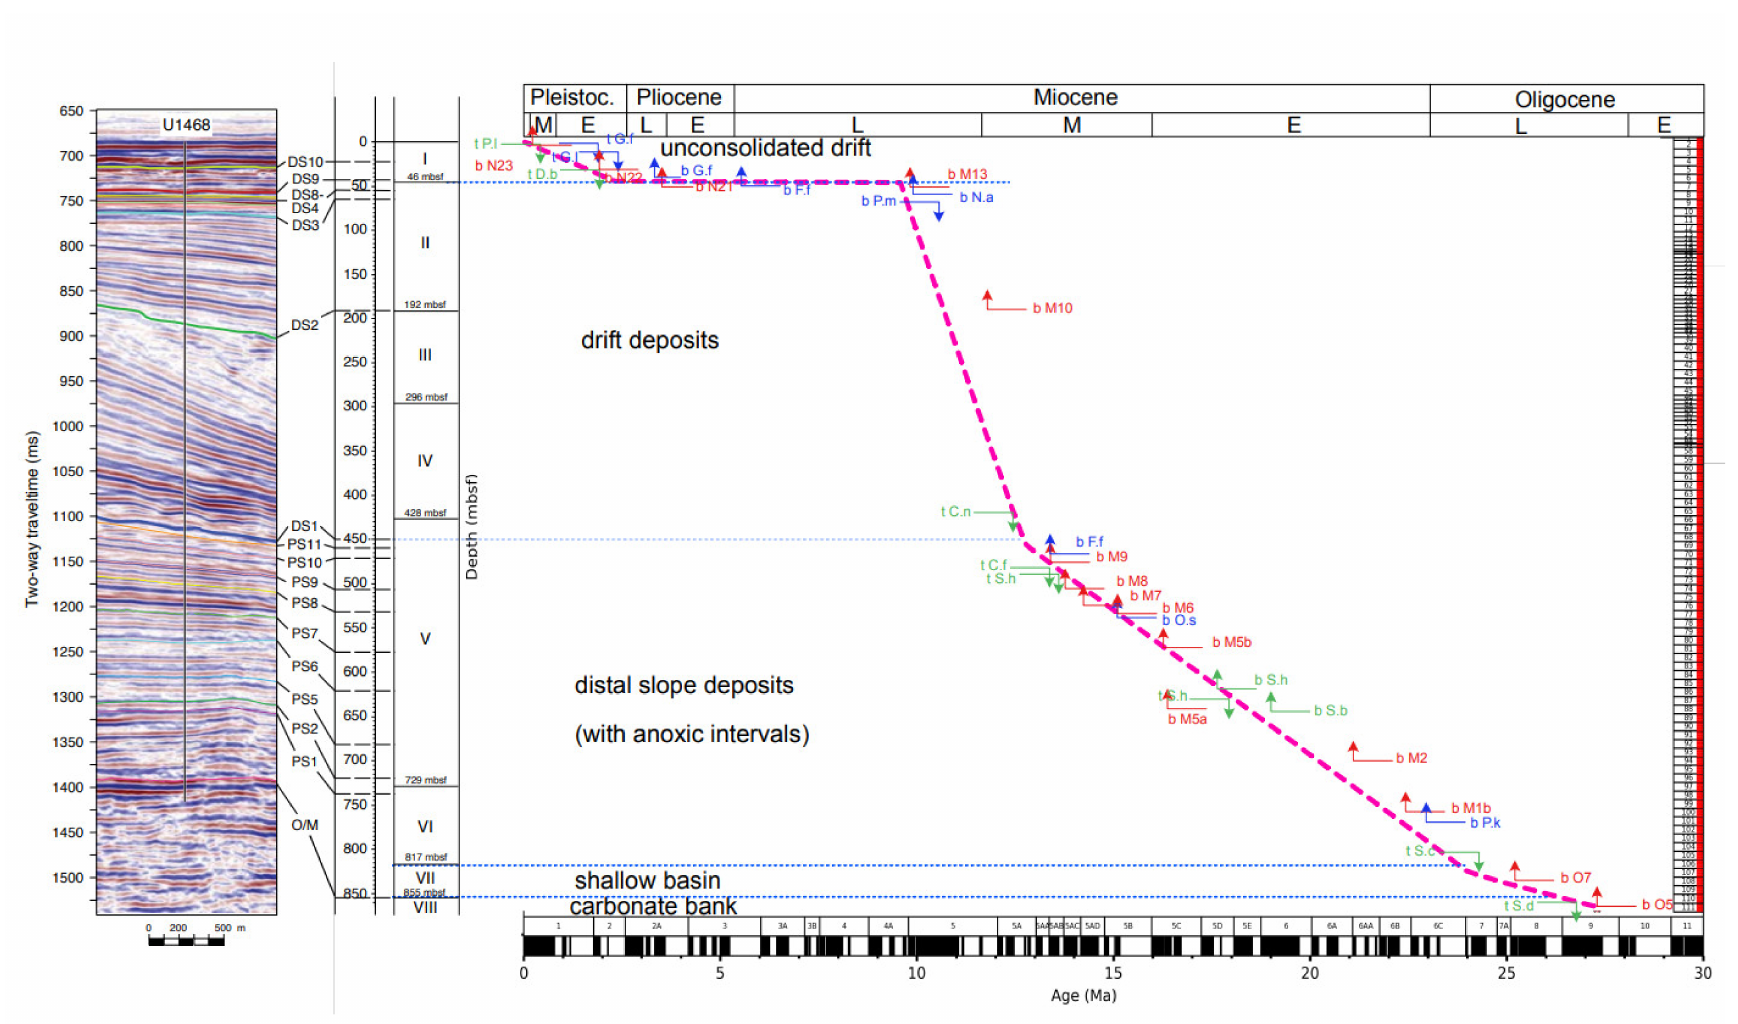
Figure 3. Sedimentation rate and seismic profile at IODP Hole 359-U1468A. The age depth/plot is obtained with TimeScaleCreator v6.3 [58]; the seismic profile is from [15]. As only core catchers and a few section samples were used the uncertainty in the position of bioevents is around 9 m. The plot codes are listed in Table